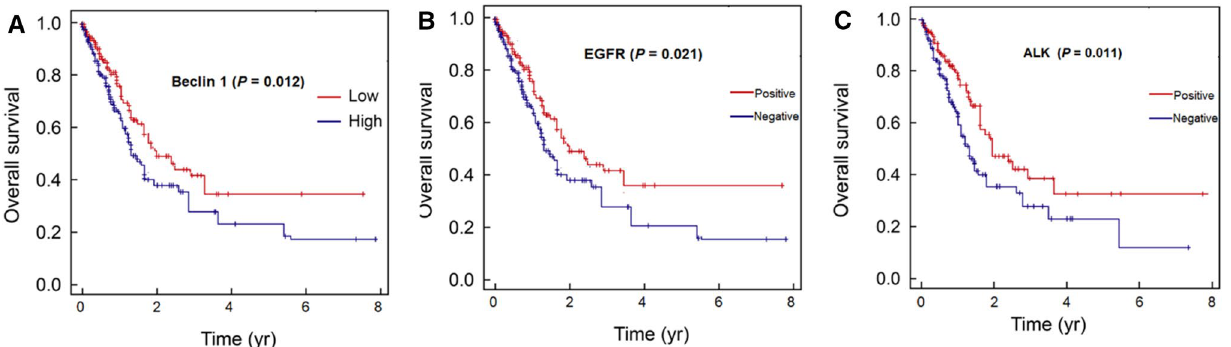
Fig. 2 The Kaplan–Meier survival analysis of non-squamous non-small cell lung cancer patients with different Beclin 1 level, EGFR and ALK mutations